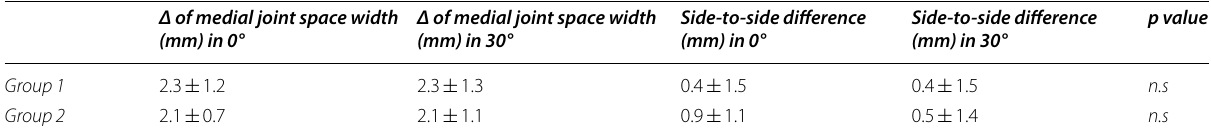
mm millimeter, SD standard deviation, Δ average change of medial joint space width between unloaded and loaded conditions, n.s. not significant